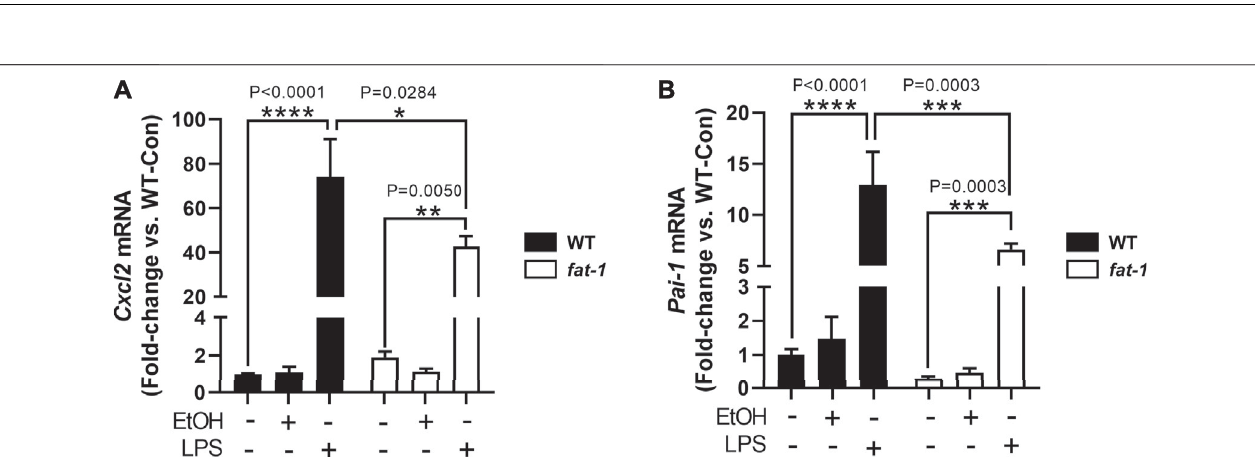
FIGURE 5 | Expression of Cxcl2 and Pai-1 in BMDMs. (A) Expression of Cxcl2 and (B) Pai-1 in EtOH and LPS-treated BMDMs isolated from WT and fat-1 mice. * p < 0.05, ** p < 0.01, *** p < 0.001, **** p < 0.0001, one-way ANOVA (comparisons not signi fi cant if unlabeled). Experiment was performed twice with consistent results.